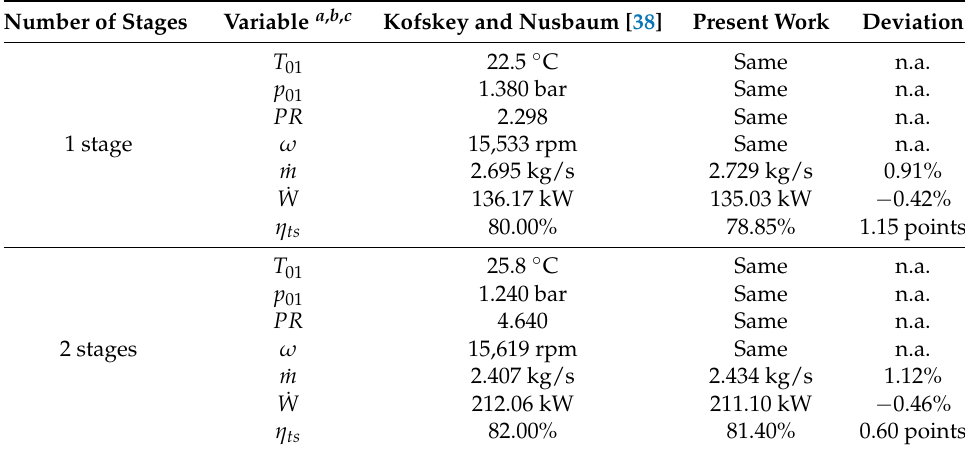
Table 2. Validation of the axial turbine model against experimental